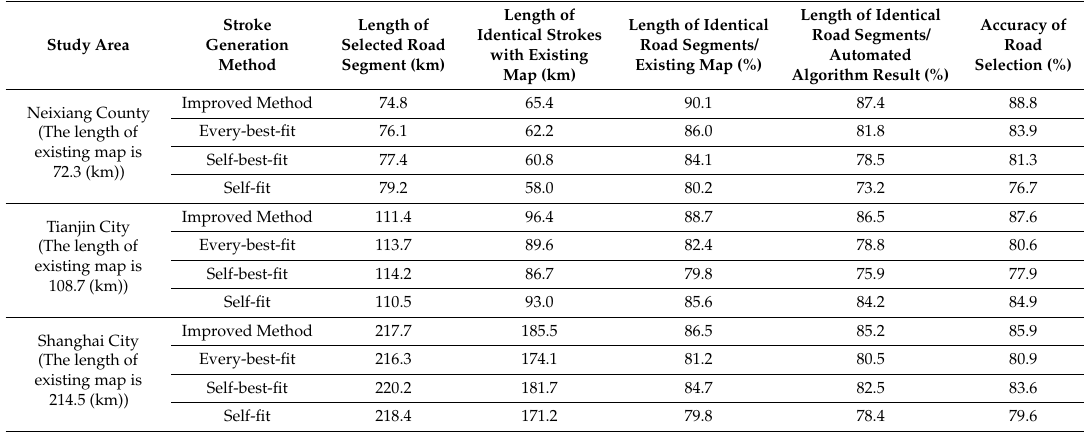
Table 6 . Statistics results of different stroke generation methods. Table 6. Statistics results of different stroke generation